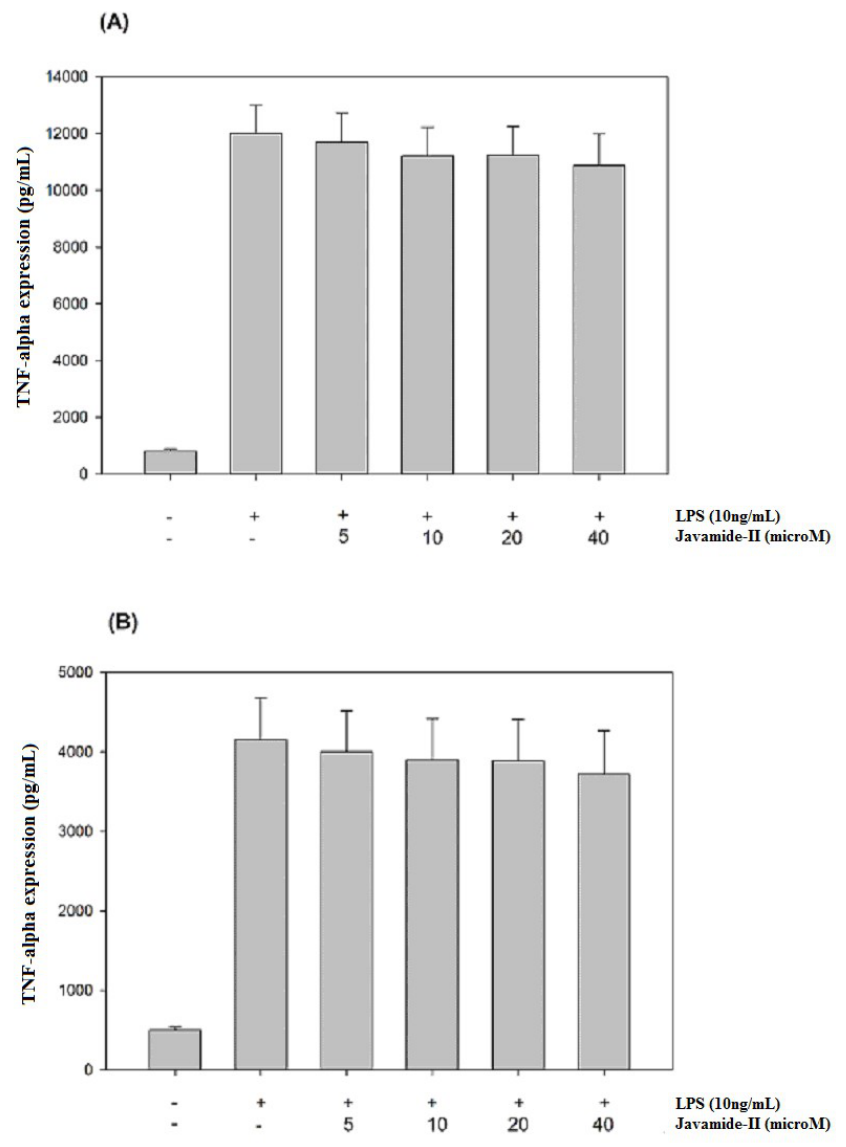
Figure 2. The effects of javamide-II on the expressions of TNF-alpha and IL-1beta. The productions of TNF-alpha ( A ) and IL-1beta ( B ) were determined at the concentrations of javamide-II (0, 5, 10, 20 and 40 µM) in LPS-treated PMA-differentiated THP-1 cells. Data points are shown as the means ± SD ( n = 7).